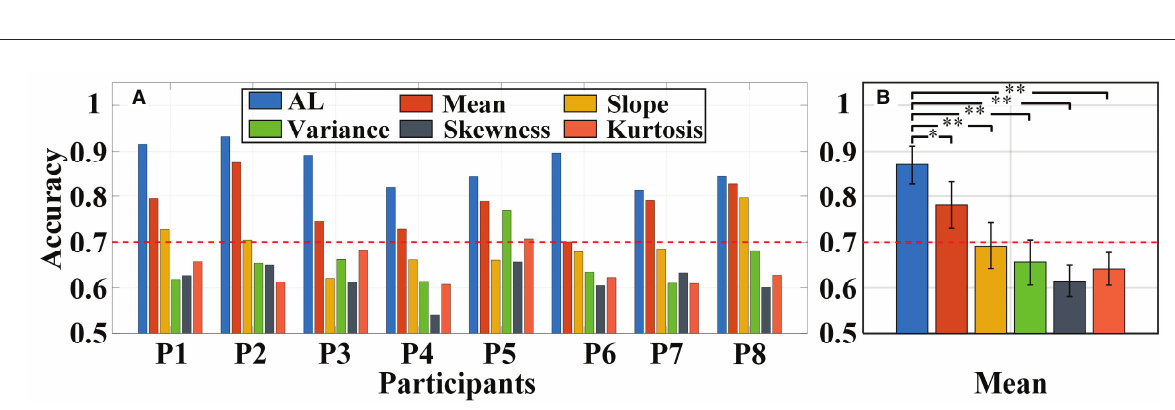
FIGURE11 Classification accuracy of MA vs. MS obtained using the same a-GMM classifier based on different features extracted from single-trial data of all participants: (A) Individual accuracy and (B) average accuracy. Error bars indicate the standard deviations, *Represents the significant difference, * p < 0.01 and ** p < 0.001. The red dashed line indicates 70% classification accuracy of effective binary BCI communication.